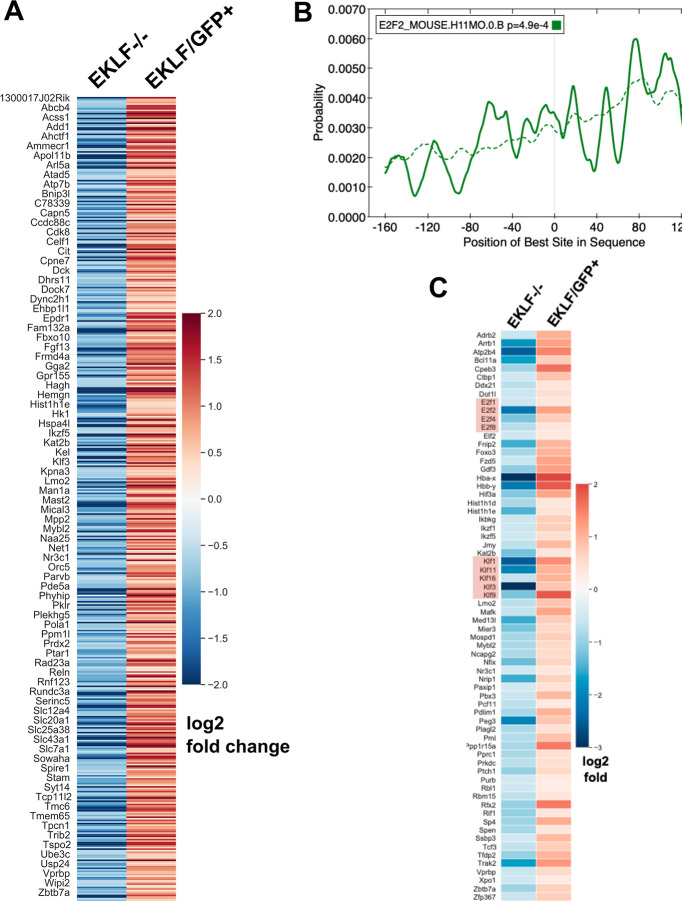
EKLF-dependent genes expressed in F4/80+ fetal liver (FL) macrophages.(A) Heatmap showing log2-fold change expression in EKLF-/- over WT and EKLF/GFP+ over EKLF/GFP- of all the 504 EKLF-dependent genes in F4/80+ FL macrophages (source data: Figure 5—figure supplement 1—source data 1). One in every six genes’ name is displayed for visibility. (B) Centrimo analysis of E2f2 promoter of EKLF-dependent genes showing differential motif enrichment of E2f2 motifs (source data: Figure 5—source data 2, 3). Dotted line depicts the expected probability of occurrence of the E2f2 motif in the background dataset (see 'Materials and methods'). (C) Heatmap showing log2-fold change expression of potential EKLF-dependent transcription factors (source data: Figure 5—figure supplement 1—source data 1). Red boxes highlight the lineage Klf transcription factors and the cell-cycle E2f transcription factors.Figure 5—figure supplement 1—source data 1.Expression values of EKLF-dependent genes.